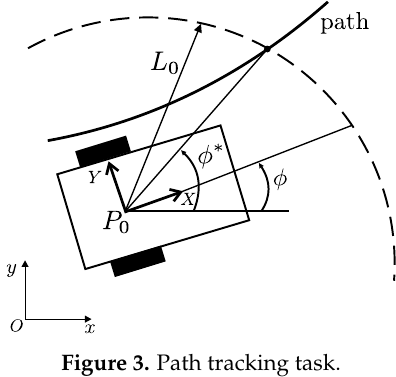
Figure 3. Path tracking